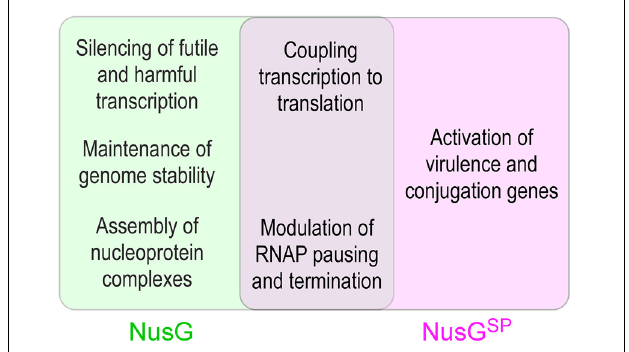
FIGURE 1 | Unique and overlapping cellular functions of housekeeping E. coli NusG and its specialized